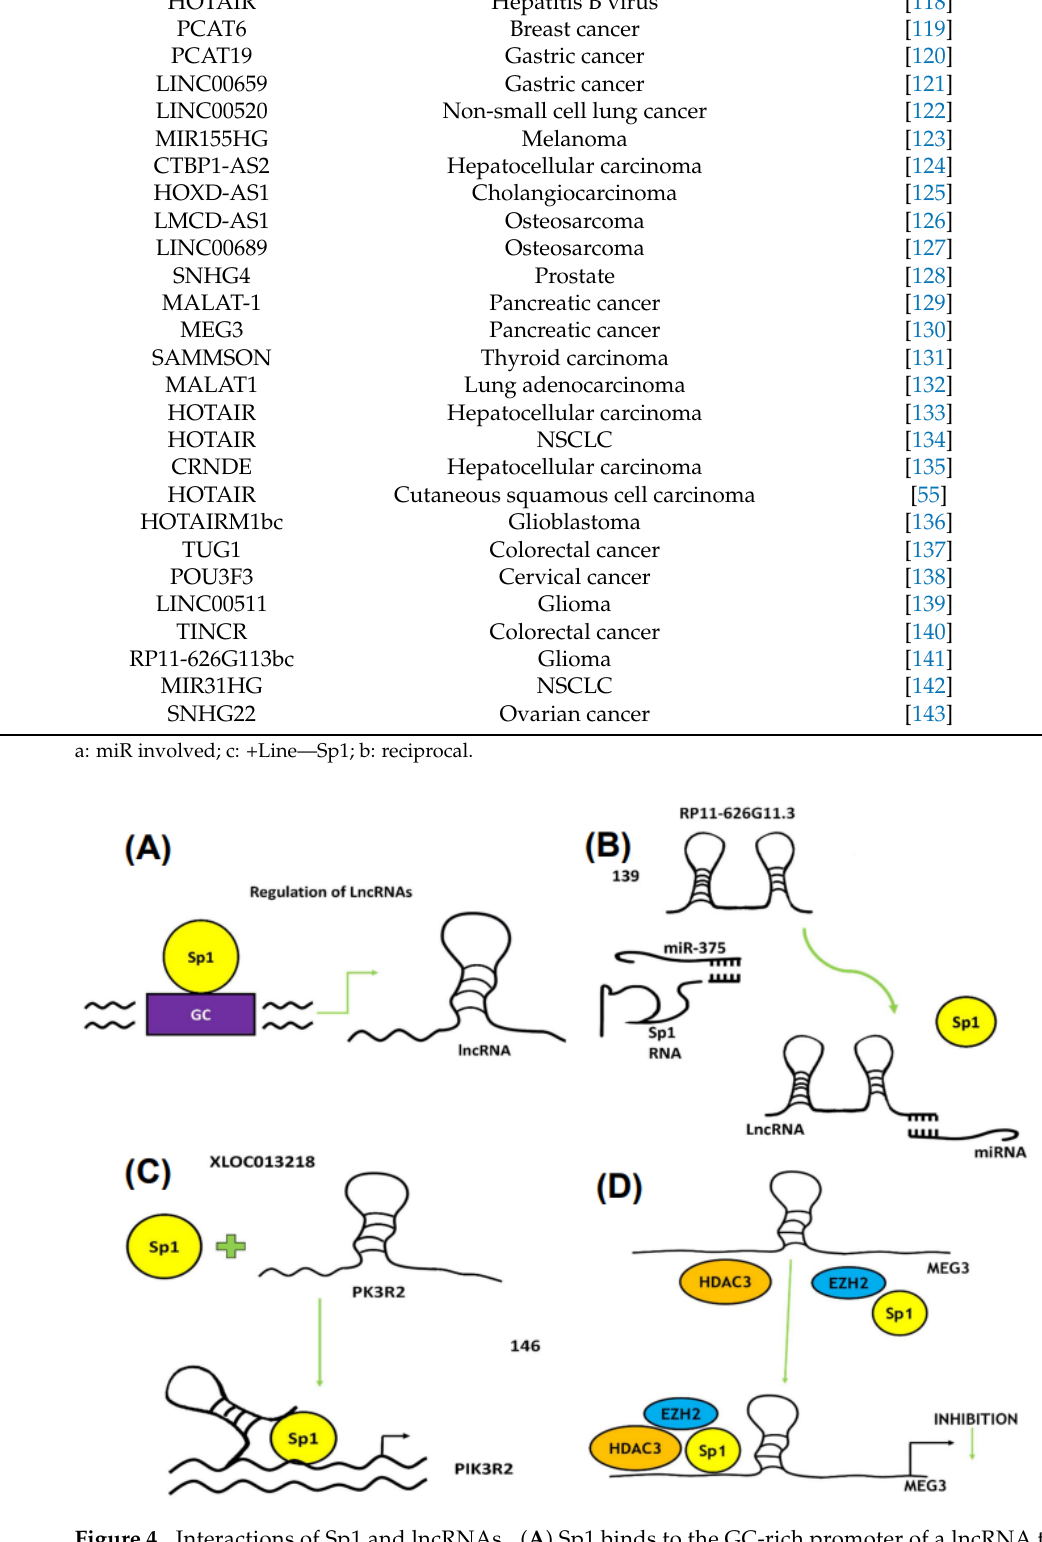
Sp transcription factors are prognostic indicators for multiple cancers (Table 1) and interact with both miRNAs and lncRNAs (Tables 2 and 3) to facilitate cancer cell prolifer- ation, survival, migration and invasion. These pro-oncogenic activities correlate with the results of knockdown studies that are consistent with their designation as non-oncogene addiction genes [66]. Despite these facts, anticancer agents that specifically target SpTFs are not being developed currently for clinical applications, even though several small mol- ecules that are used for cancer and other chemotherapies also downregulate/degrade Sp1, Sp3 and Sp4. These include HDAC inhibitors, metformin, bardoxolone methyl, borte- zomib and some non-steroidal anti-inflammatory drugs (NSAIDs). Two review articles from this laboratory have previously outlined compounds that downregulate or induce degradation of Sp TFs [4,150], and these include drug-induced ROS, proteasome-depend- ent degradation, cannabinoid receptor (CBR) induced responses, zinc depletion and ki- nase/phosphatase pathways. Studies in this laboratory have investigated drugs that acti- vate most of these pathways [4,150] and result in coordinated downregulation of Sp1, Sp3 and Sp4. Most other studies have focused on drug-induced downregulation of only Sp1, and it can be assumed that in many cases, downregulation of Sp1 is accompanied by par- allel decreases in Sp3 and Sp4. Multiple classes of compounds decrease expression of Sp TFs in cancer cells, and these include structurally diverse ROS inducers, non-steroidal anti-inflammatory drugs (NSAIDs), cannabinoids and other drugs including retinoids,